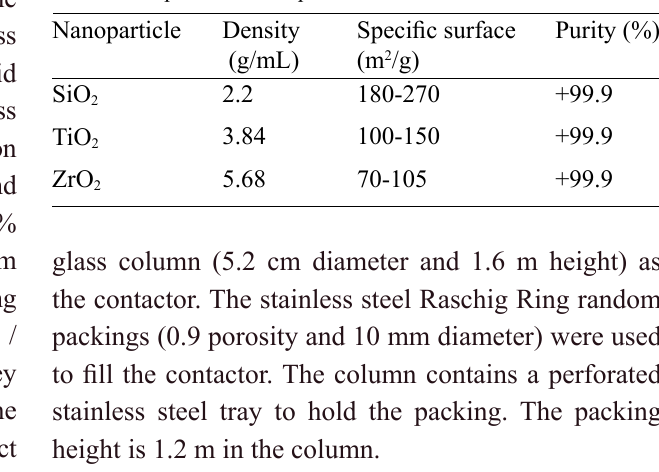
Table 2. Properties of